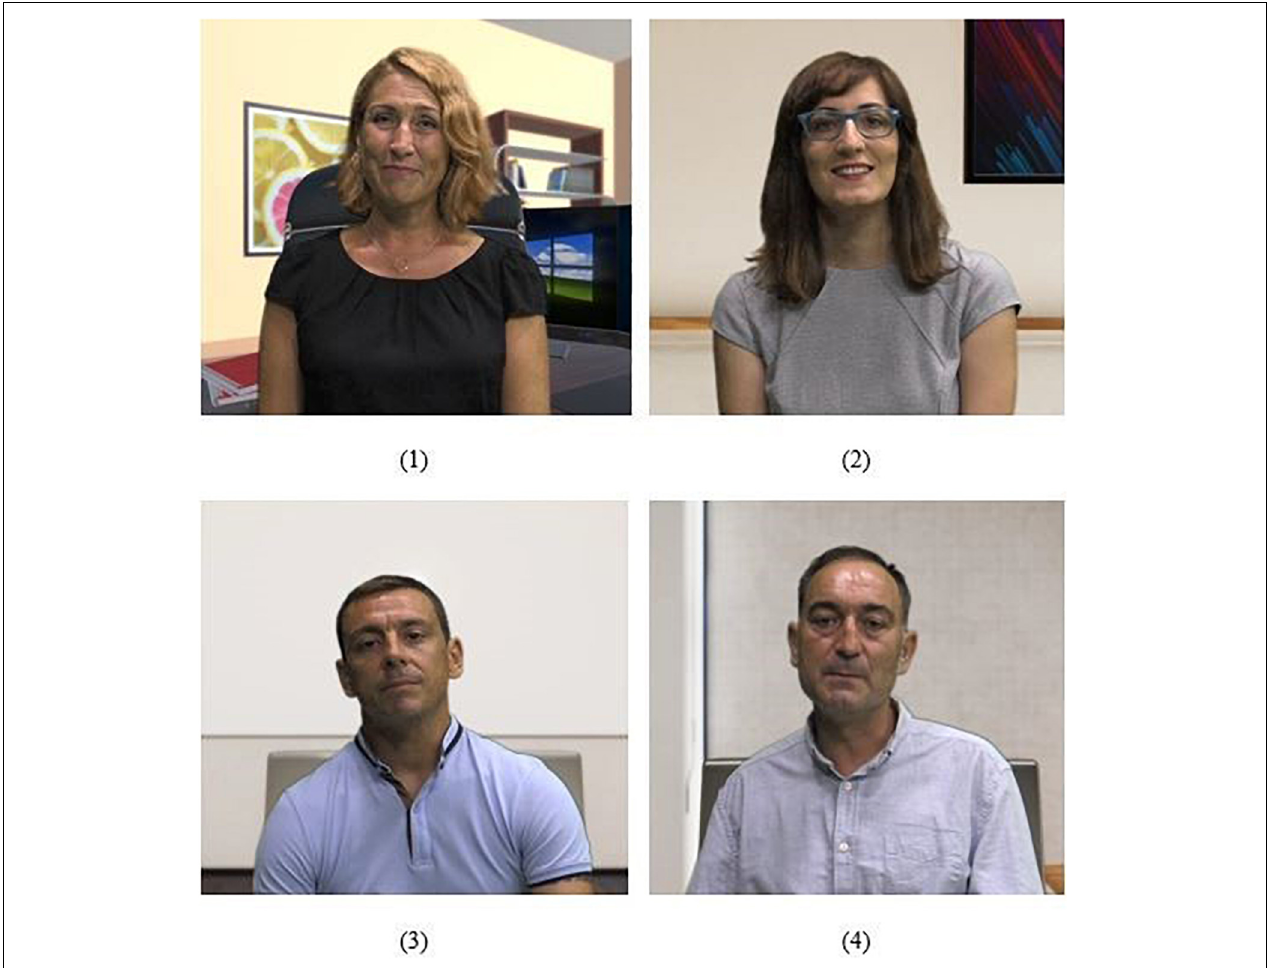
FIGURE 1 | Virtual agents’ characterisation (1) transactional leader, (2) transformational leader, (3) transactional leader, and (4) passive-avoidant